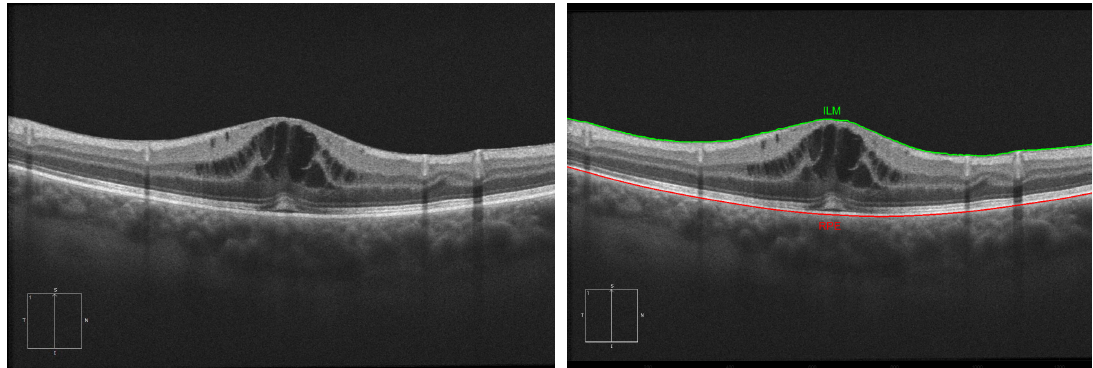
Figure 5. Example of the segmentation of the Inner Limiting Membrane (ILM) and Retinal Pigment Epithelium (RPE) retinal